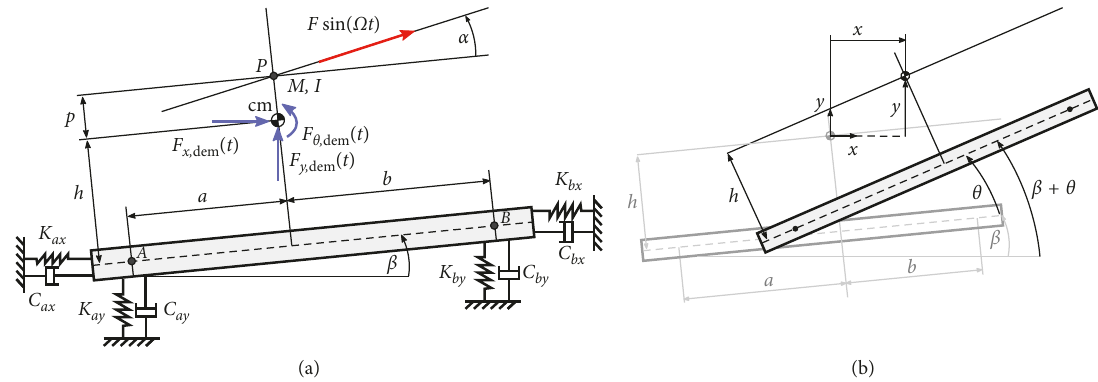
Figure 1: Model geometry: (a) equilibrium position and (b) degrees of